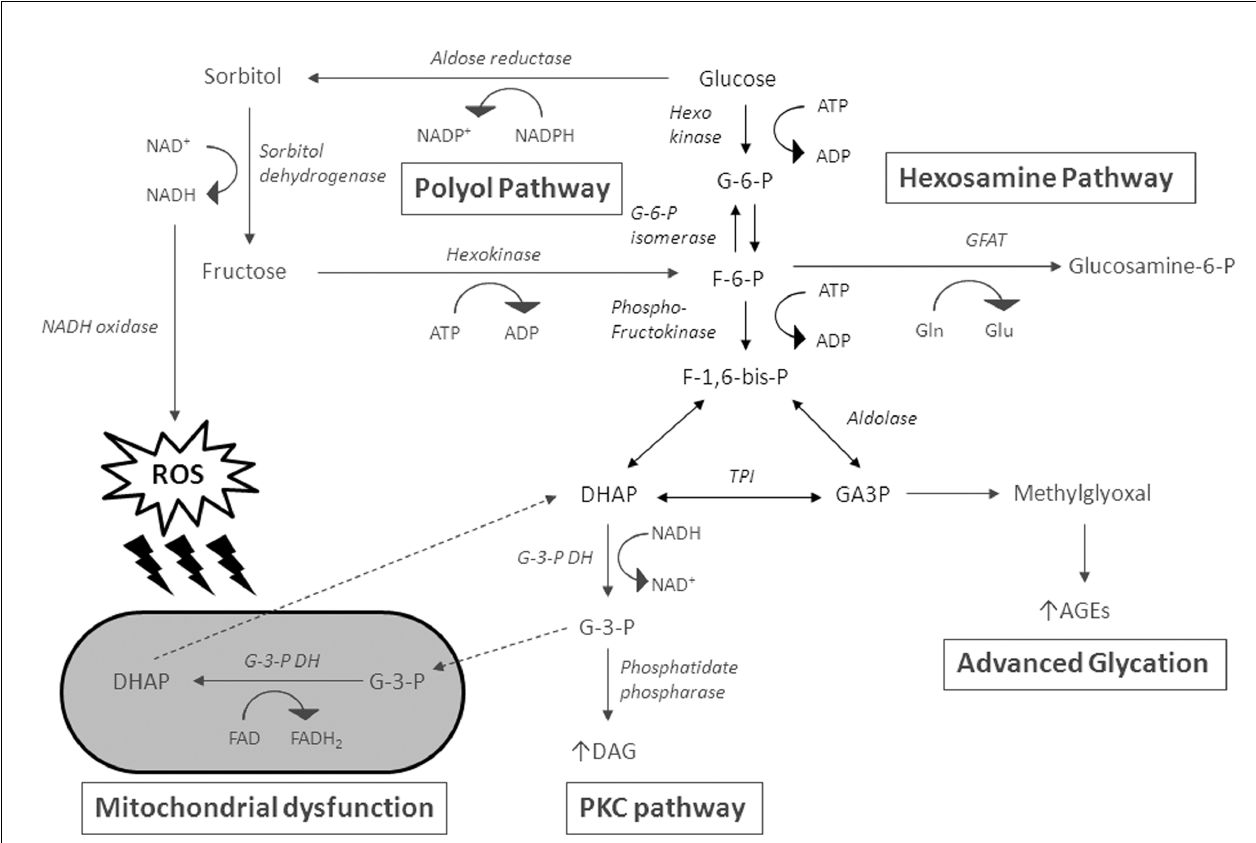
interconvertible by triosephosphate isomerase.They can lead to the formation of methylglyoxal, resulting in advanced glycation end-product. DHAP can further be converted to diacylglycerol (DAG), leading to PKC activation.The continuous conversion of glycerol-3-phosphate (G-3-P) to DHAP results in concomitant transfer of electrons from reduced cytosolic NADH to mitochondrial oxidized FAD, which can generate high mitochondrial membrane potentials and inhibition of the electron transport chain at complex III.The oxidation of NADH by NADH oxidase produces reactive oxygen species (ROS), which can attack the mitochondrial